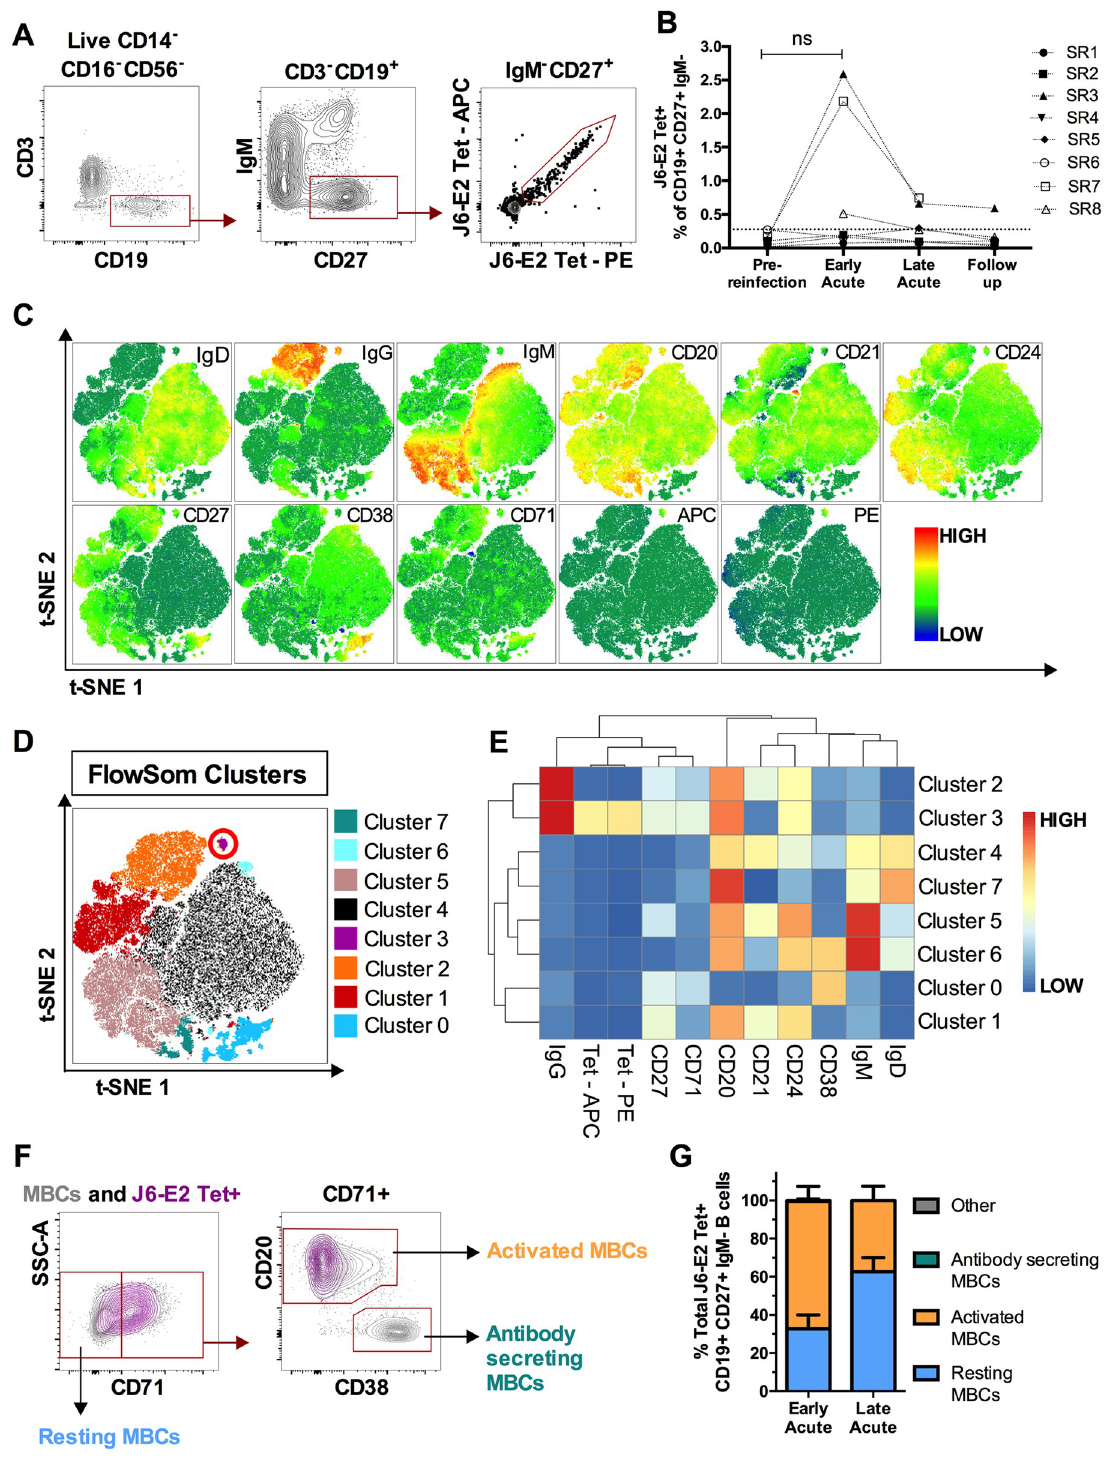
Fig 3. Activation and expansion of E2-specific MBCs following HCV reinfection. ( A ) Representative gating strategy for detection of class-switched, E2-specific MBCs (CD3 – CD14 – CD16 – CD56 – CD19 + CD27 + IgM – E2tet + ) in total PBMCs. ( B ) Longitudinal frequencies of E2-specific (J6-E2 Tet + ) MBCs at the indicated time points (see Fig 1A). Threshold of detection of E2-specific MBCs (dotted line) was 0.277% (mean detection + 2SD from 5 naive PWID). ( C ) Global t-SNE projection of CD3 – CD14 – CD16 – CD56 – CD19 + B cells from three subjects (SR3, SR7 and SR8) at the Early Acute time point, concatenated and overlaid. Each t-SNE projection reflects the expression of the